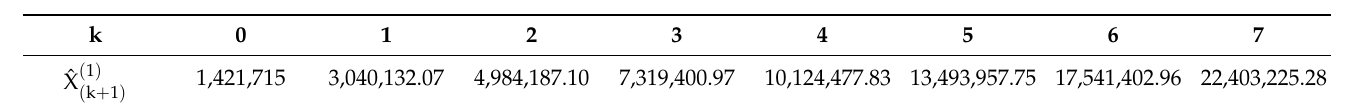
Table 12. Values of ˆX